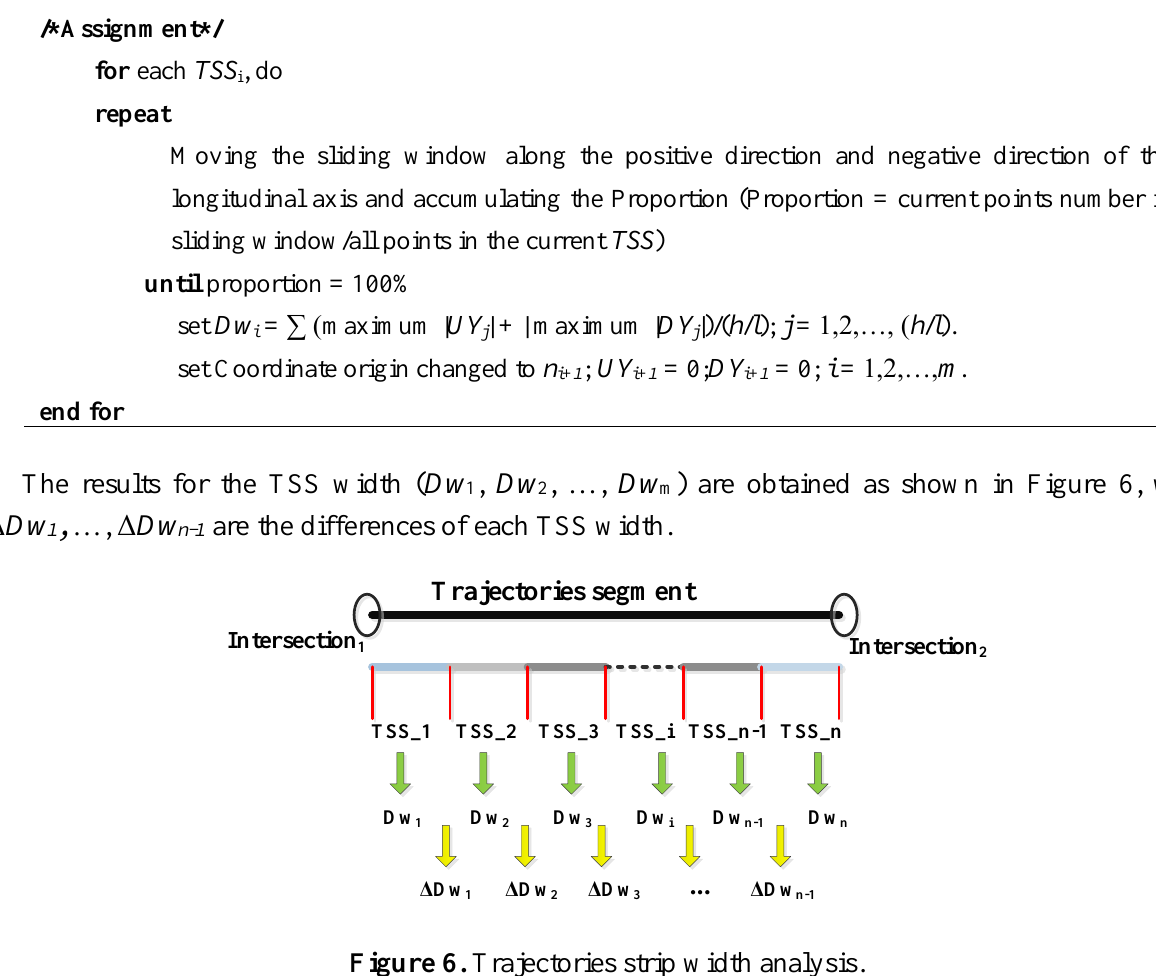
Figure 6. Trajectories strip width